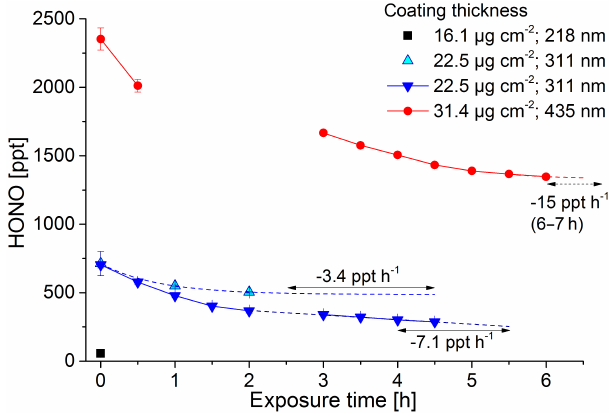
Figure 6. HONO formation on three different BSA coating thick- nesses, exposed to 20ppb of NO 2 under illuminated conditions (seven VIS lamps). The HONO concentrations were scaled to reac- tion tube coverage (black: 100% of reaction tube was covered with BSA; light blue: 70% of tube was covered; red: 50% of tube was covered with BSA). The middle thick coating (22.46µgcm − 2 ) was replicated and studied with different reaction times (cyan and blue triangle). Solid lines (with circles or triangles) present continuous measurements; when those are interrupted, other conditions (e.g., light intensity, NO 2 concentration) prevailed. Dotted lines show in- terpolations and are meant to guide the eyes. Arrows indicate the intervals in which the shown decay rates were determined. Error bars indicates SDs from 10 to 20 measuring points